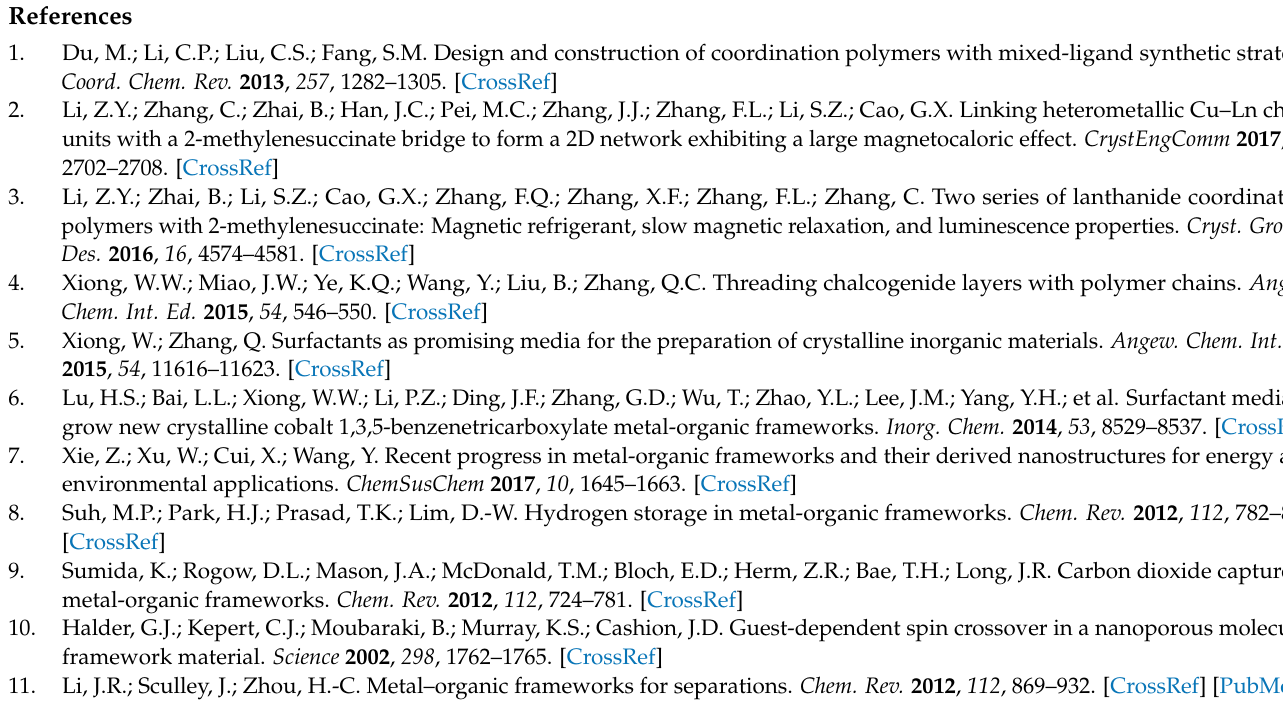
and polymer 1 . Figure S2: Polymer structure from the perspective of the etdipy moiety (perchlorate counterion and siloxane moiety were omitted for clarity). Figure S3: Polymer structure from the perspective of the siloxane moiety (perchlorate counterion and etdipy moiety were omitted for clarity). Figure S4: Topology of the polymer network. In the topological analysis, the disordered part of the structure was omitted. Figure S5: Dielectric properties of compound 1 , including the relative permittivity ( ε (cid:48) ), dielectric loss ( ε (cid:48)(cid:48) ), and conductivity ( σ ). Figure S6: Magnetization curves versus applied magnetic field for compound 1 . Figure S7: PXRD diffractogram (blue) vs. the one simulated based on single crystal X-ray diffraction data (red). Table S1: Selected bond lengths [Å], angles [ ◦ ], and hydrogen bonds for compound 1